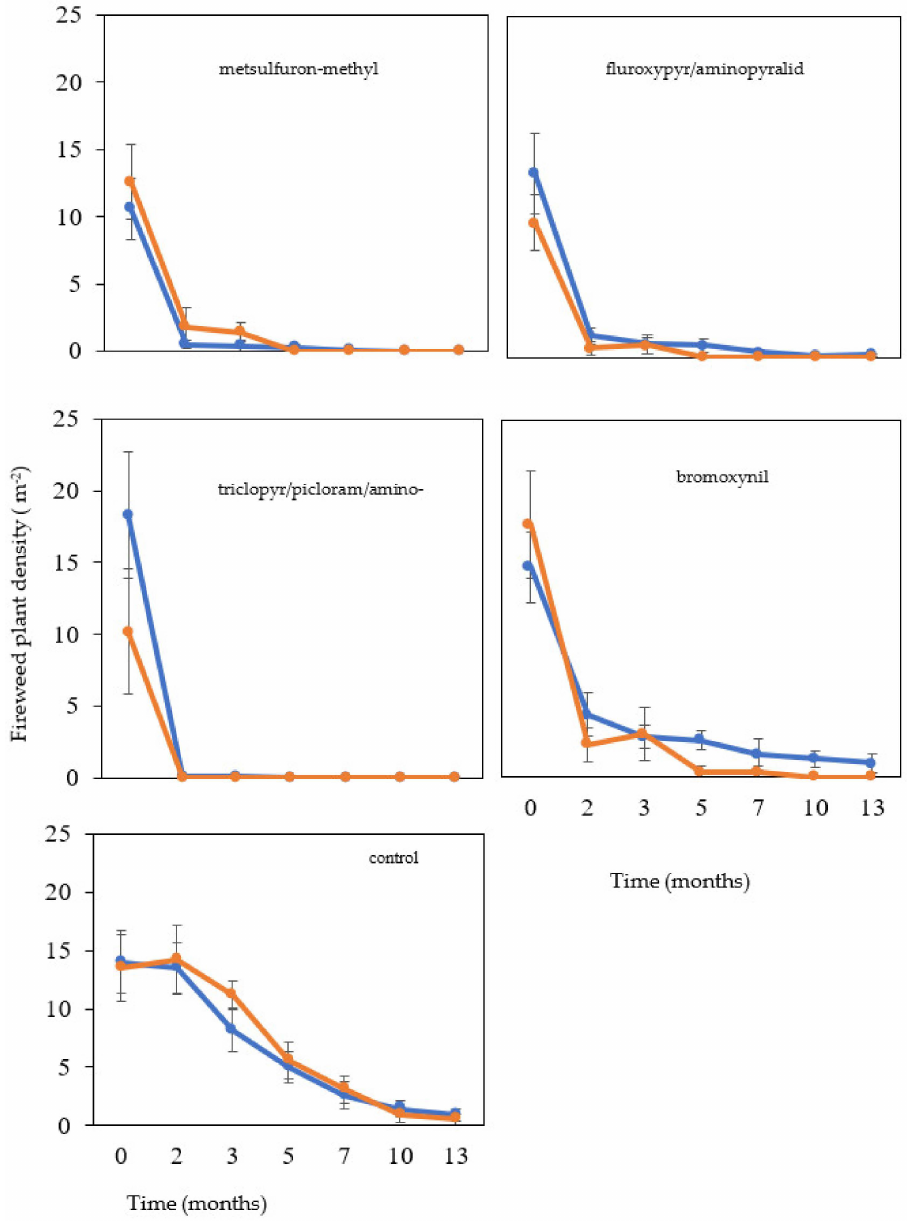
Figure 1. Fireweed plant density (m − 2 ) in two different types of field plots: those plots that had been sprayed once (blue line) and those that had been sprayed twice (orange line) recorded over time following the application of metsulfuron-methyl, fluroxypyr/aminopyralid, triclopyr/picloram/aminopyralid, bromoxynil, and control. The data are the mean ± SEM from five replicate